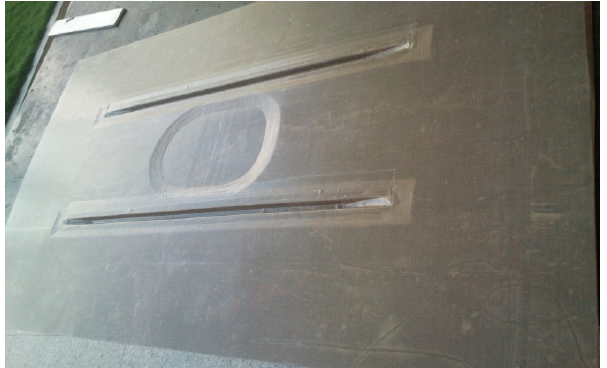
Figure 3. Caul plate after applying tool tech.